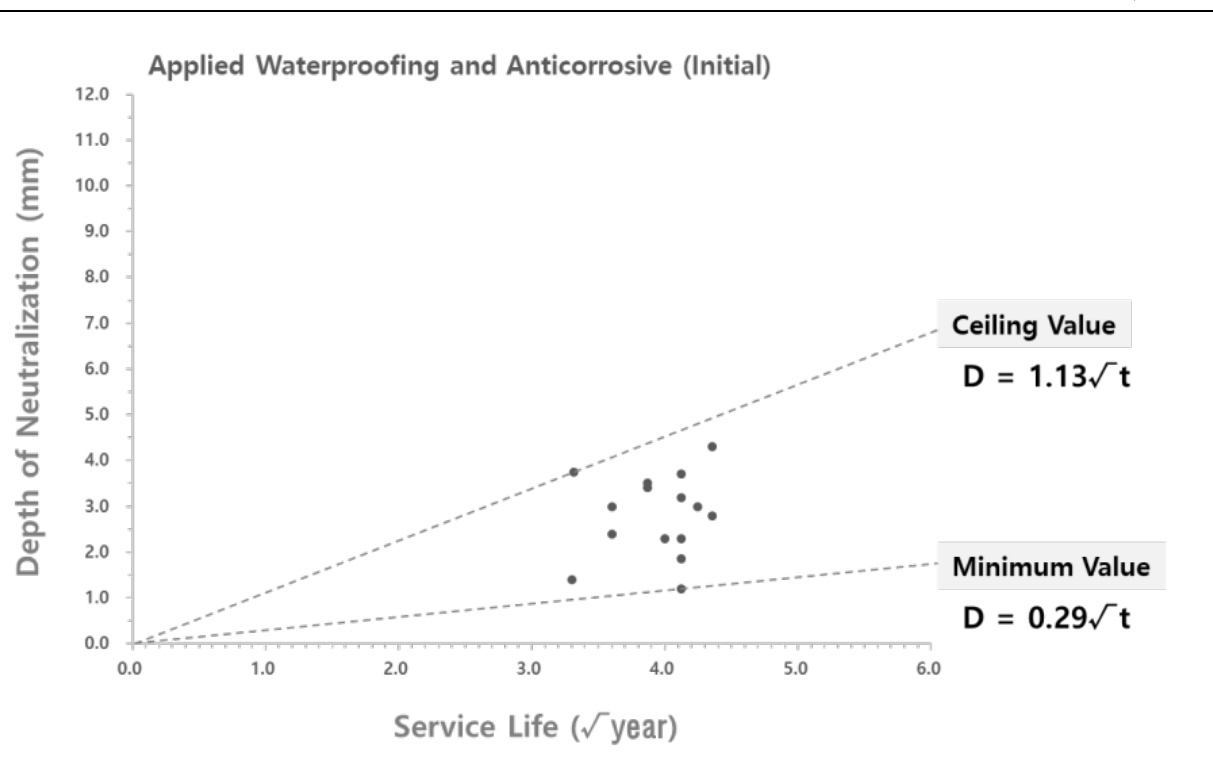
Figure 6. Carbonation depth distribution on the inner wall of the water reservoirs (waterproof- ing/anticorrosive method applied from the initial stage of service life) - reflect on-site adjustments